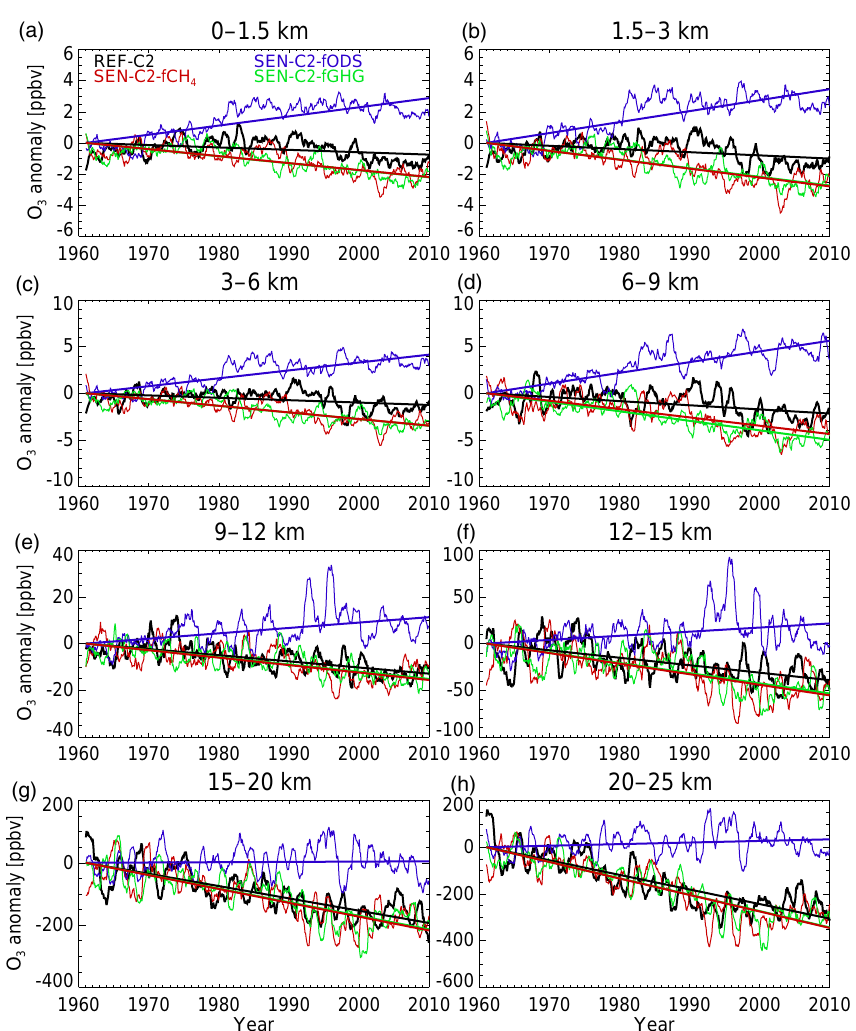
Figure 10. Modelled O 3 anomalies and linear trends at Lauder over 1960–2010, from REF-C2 (black), SEN-C2-fGHG (green), SEN-C2- fCH 4 (red), and SEN-C2-fODS (blue). Anomalies shown are smoothed with a 13-monthly filter for the purpose of display.